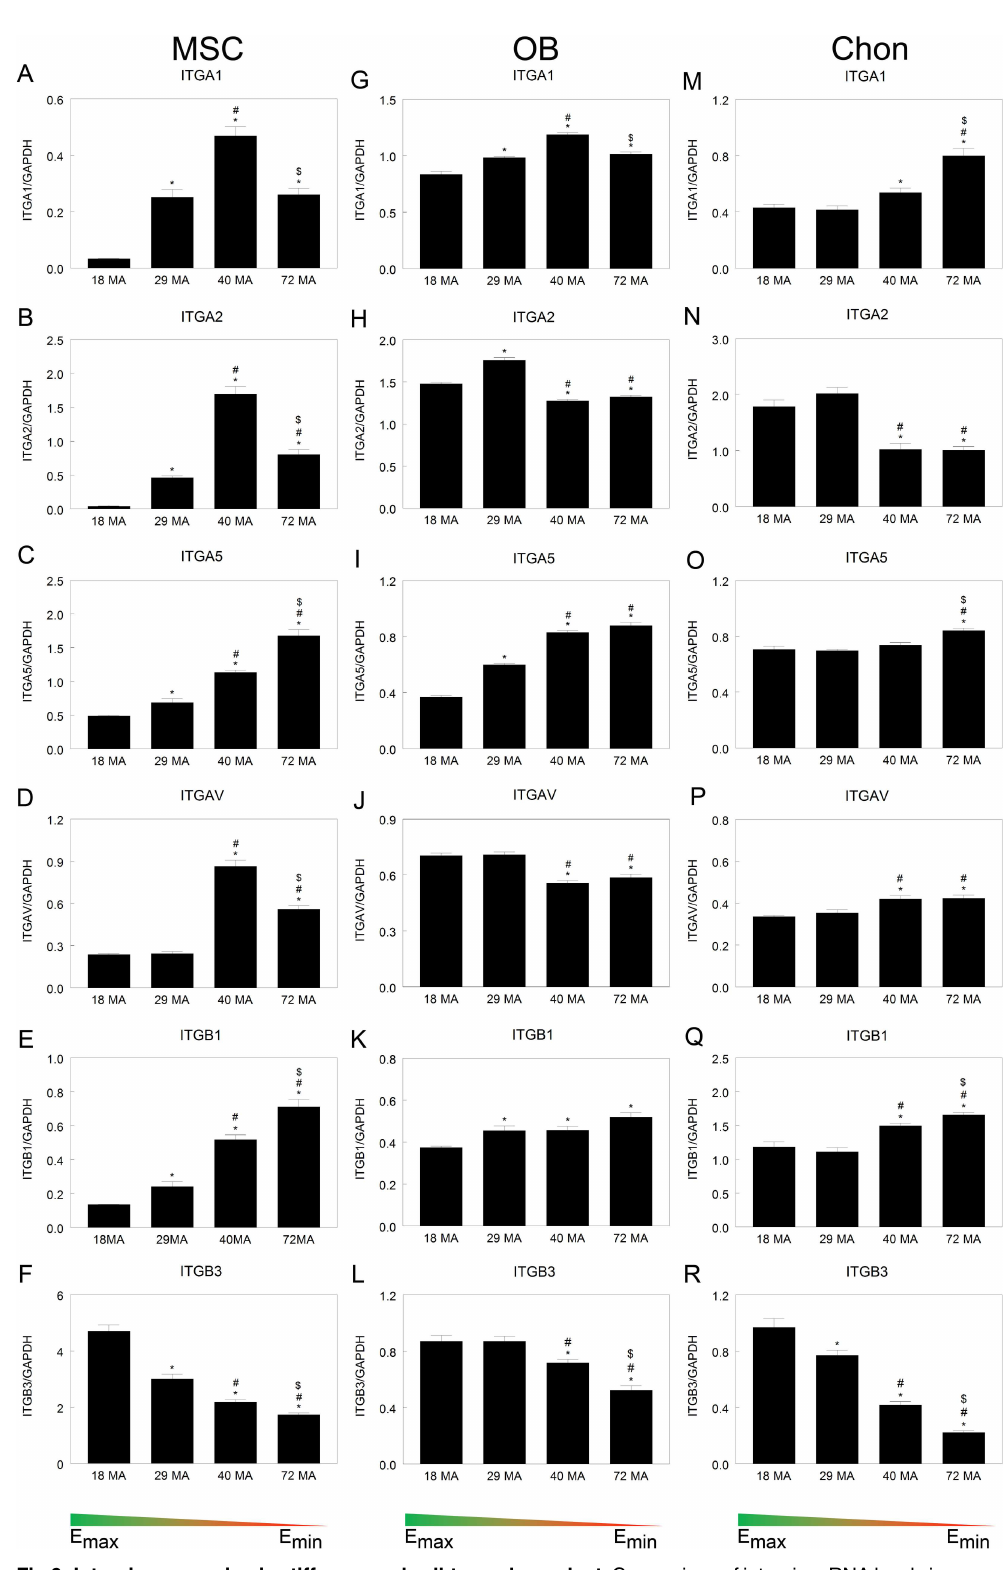
Fig 6. Integrin expressionis stiffness- and cell-type- dependent. Comparisonof integrinmRNA levels in MSCs, OBs, and chondrocytes culturedon surfaces of varyingstiffness. * P < 0.05 vs. 18 MA, # P < 0.05 vs. 29 MA, $ P < 0.05 vs. 40